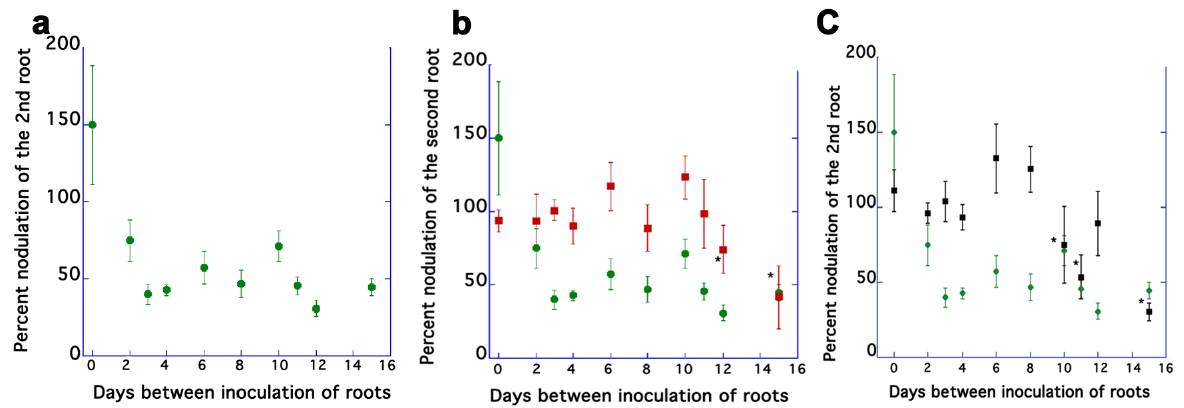
Figure 1. Persistence of the systemic suppression signal in mutant and wild type plants. ( a ) Wild type plants have consistently fewer nodules on the second root when the second root is inoculated 2–15 days after the first. Percent nodulation was calculated by dividing the mean nodule number of the second root by the mean nodule number of the first root. Values for time points 2–15 are statistically significant from time 0. ( b ) Wild type values (green dots) compared to the sunn-4 allele values (red boxes). Data points marked with * are not statistically different between wild type and mutant ( c ) Wild type values (green dots) compared to the rdn1-2 allele values (black boxes). Data points marked with * are not statistically different between wild type and mutant. Percent nodulation was calculated by dividing the mean nodule number of the second root by the mean nodule number of the first root. Statistical comparisons among means are based on factorial ANOVA followed by pairwise mean comparisons. Data are shown as means ± SE. ( n = 6 to 47 plants for each time point per